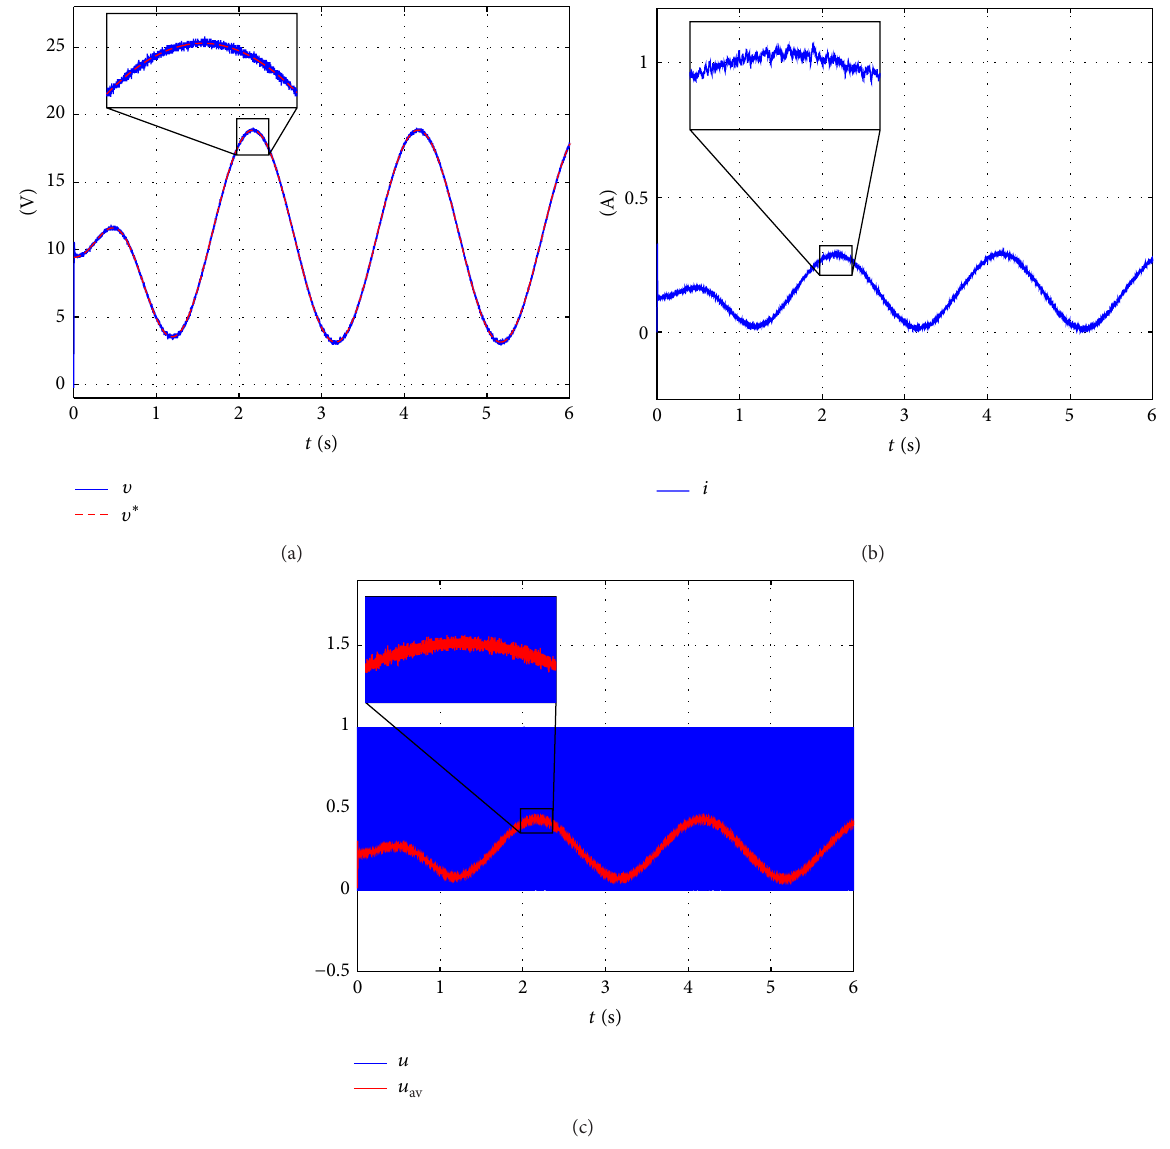
Figure 6: Case (i) via Σ - Δ